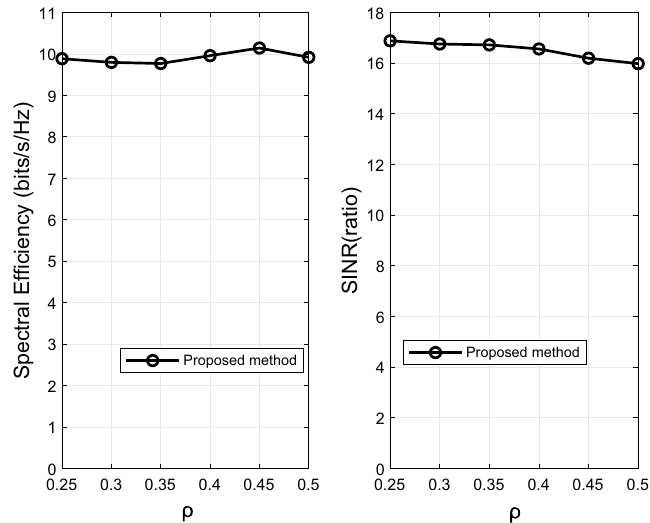
Fig. 2 The communication spectral efficiency and radar signal-to-noise ratio versus different penalty coefficients